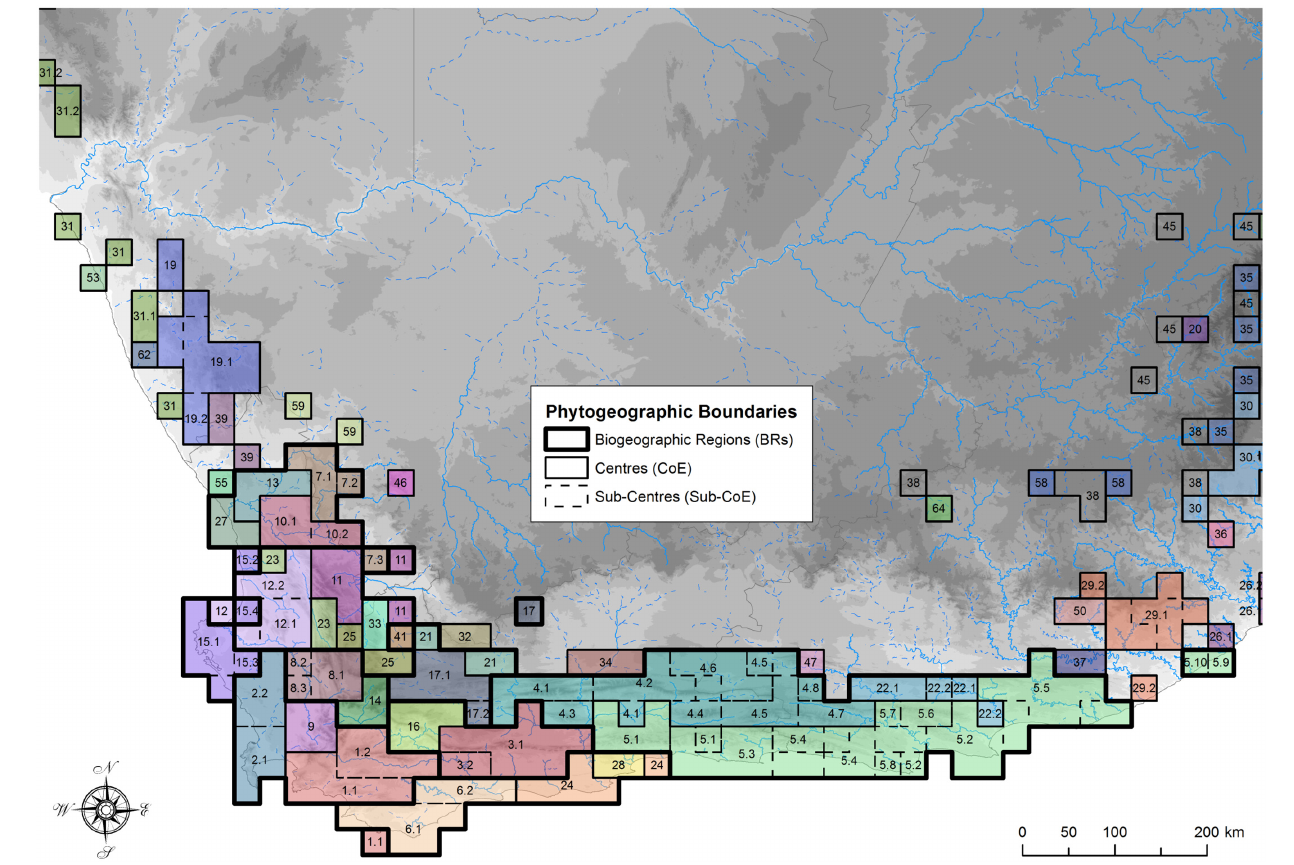
Fig 6. CFR centres of endemism, sub-centres of endemism and biogeographic regions retrieved. Names of CoEs, Sub-CoEs and BRs, as well as the geographic and taxonomic properties of these units are provided in S3 Table.